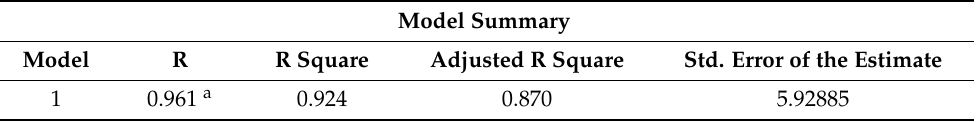
Table 6. Summary of the variables for the regression equation for confidence rates.